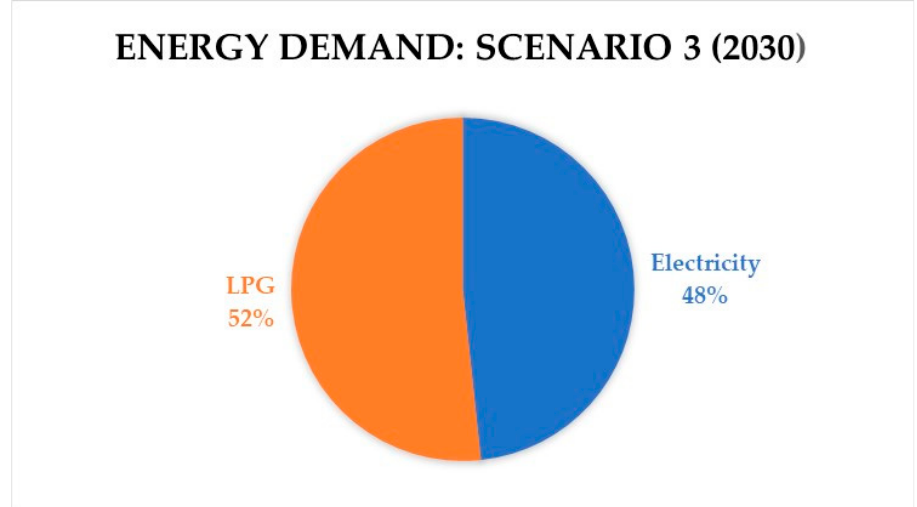
Figure 9. Scenario 2. Sankey diagram for 2030, residential sector (The figure shows the electricity losses given by the local distribution company. In addition, the losses of conversion of solar energy to heat are displayed. Losses due to the commercialization and distribution of LPG have not been included).